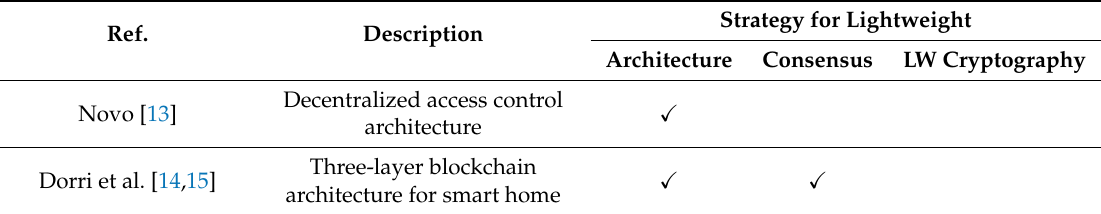
Table 1. Taxonomy of strategies of existing blockchain-based